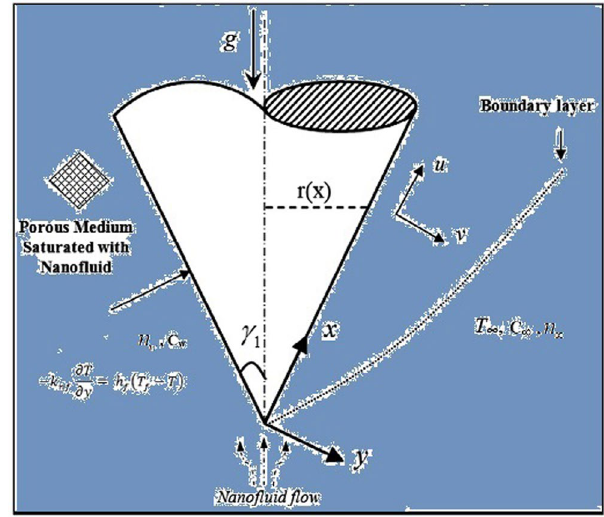
Figure 1. Schematic model representing the flow